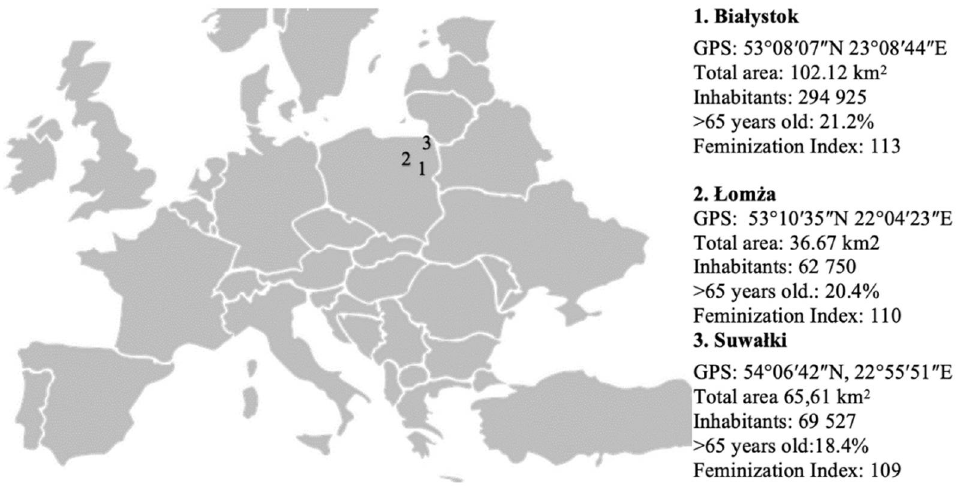
Figure 1. Characteristics of the studies cites.